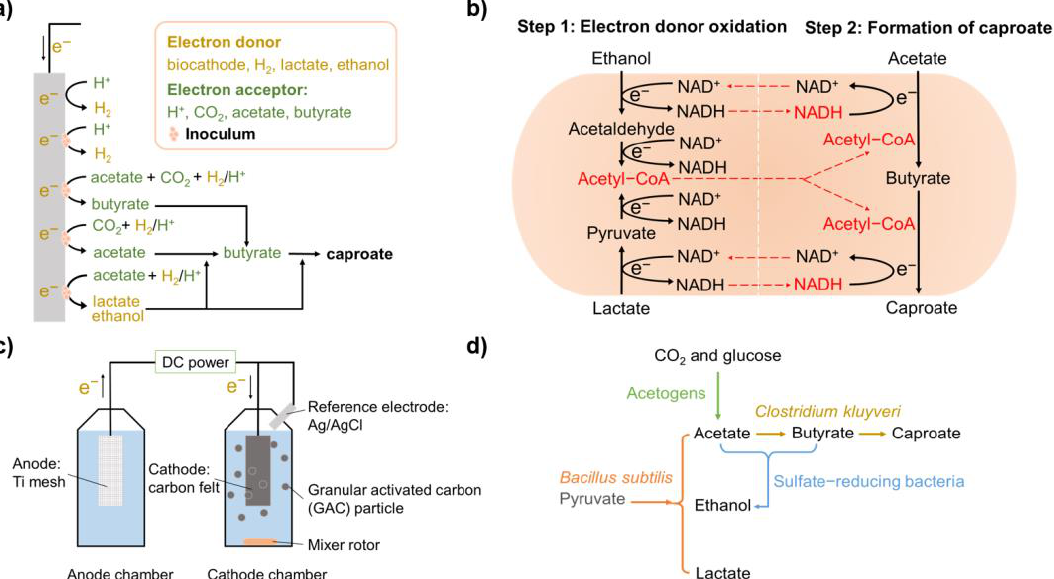
Figure 4. ( a ) All possible pathways occurring in MCCAs bioelectric production systems with acetate and CO 2 as substrates [43]; ( b ) reverse β oxidation mechan ism and electron transfer direction [24]; ( c ) schematic diagram of fluidized cathode electric fermentation system [50]; ( d ) cooperation of microorganisms in bioaugmentation systems [44,45,61,71].